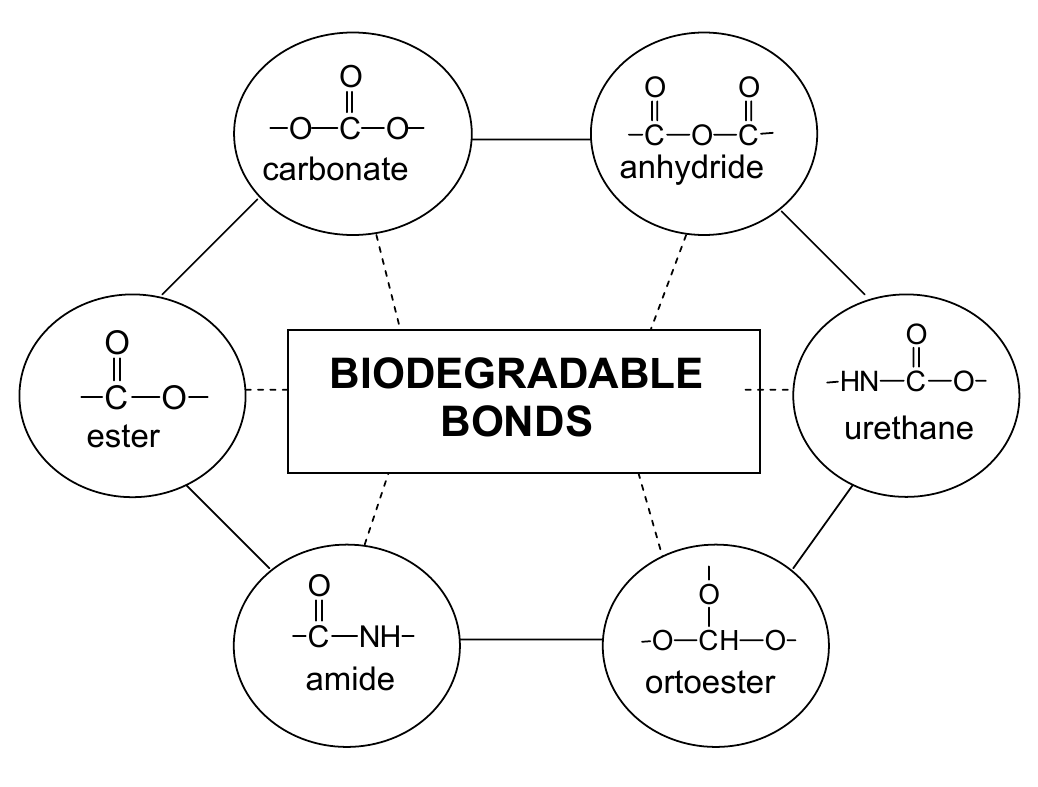
Figure 2 . Biodegradable bonds used to conjugate bioactive molecules to polymer